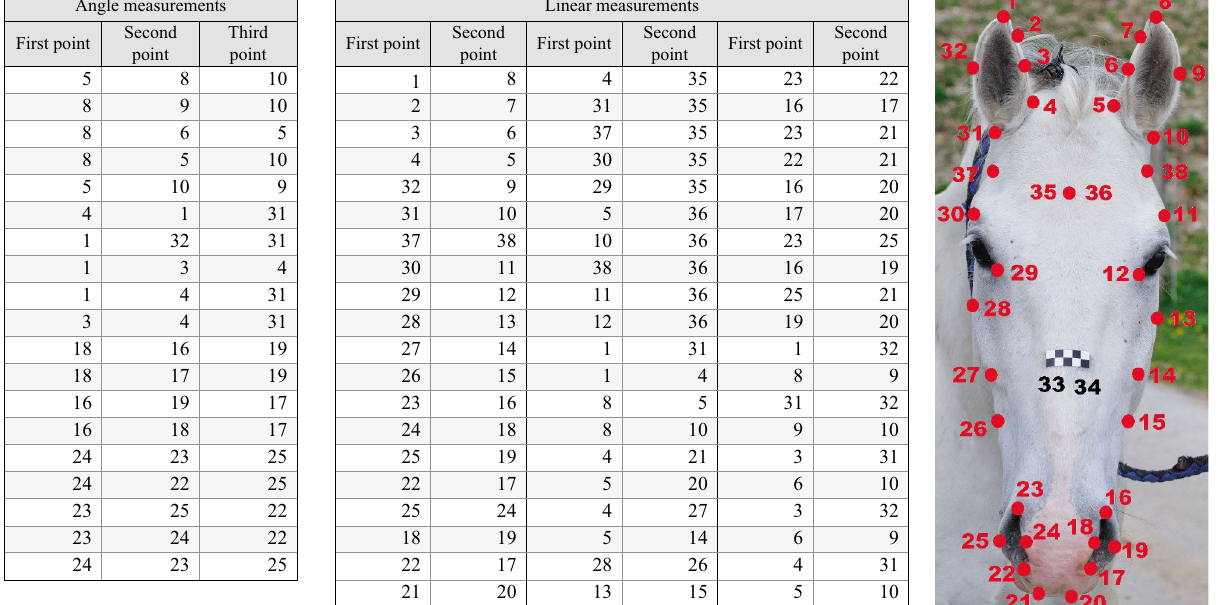
characteristics of the horses. Having established the 4 characteristically distinct groupings of horses based on behaviour, we tested the pre- dictive power of anatomical characteristics for classification into these groups. We also computed the coefficient of determination (R2) and Pearson correlation coefficient between the anatomical, physiological and behavioural characteristics and HR responses in behavioural tests for all the horses and for each of the groups separately in order to directly test the relations between the two types of measurements. The two coefficients indicate the predictive value of each individual anatomical measurement for each individual behavioural characteristic independently. This gives a more fine-grained and robust indication of the relations, which are independent of modelling technique and clustering.